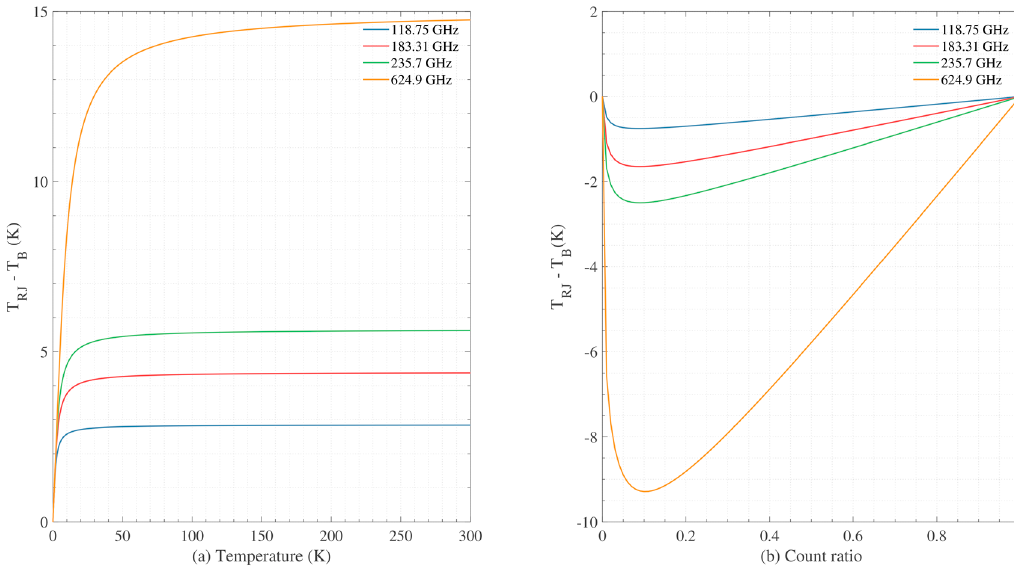
Figure 2. The variations of calibration errors with temperature and the count ratio induced by the R–J approximation: ( a ) variations with temperature; ( b ) variations with the count ratio. Here 𝑇 (cid:3003) is calculated by Equation (3), and 𝑇 (cid:3019)(cid:3011) is obtained from replacing 𝐼 by 𝑇 with 𝑇 (cid:3004) and 𝑇 (cid:3009) set to 2.73 and 300 K, respectively. The count ratio means (cid:3004) (cid:3250) (cid:2879)(cid:3004) (cid:3252) (cid:3004) (cid:3257) (cid:2879)(cid:3004) (cid:3252)